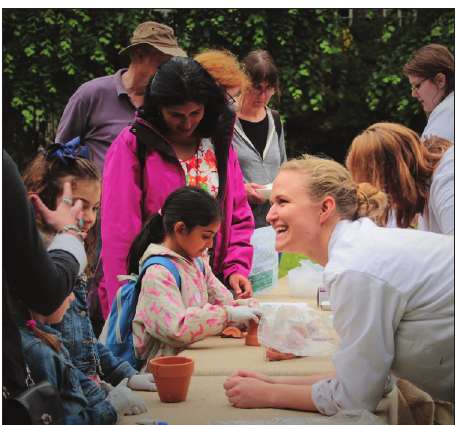
Figure 3: MSc Conservation for